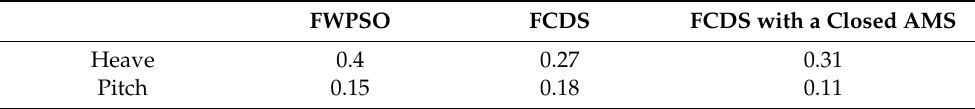
Figure 8. RAOs of the heave and pitch. Table 2. Natural frequencies based on the RAOs